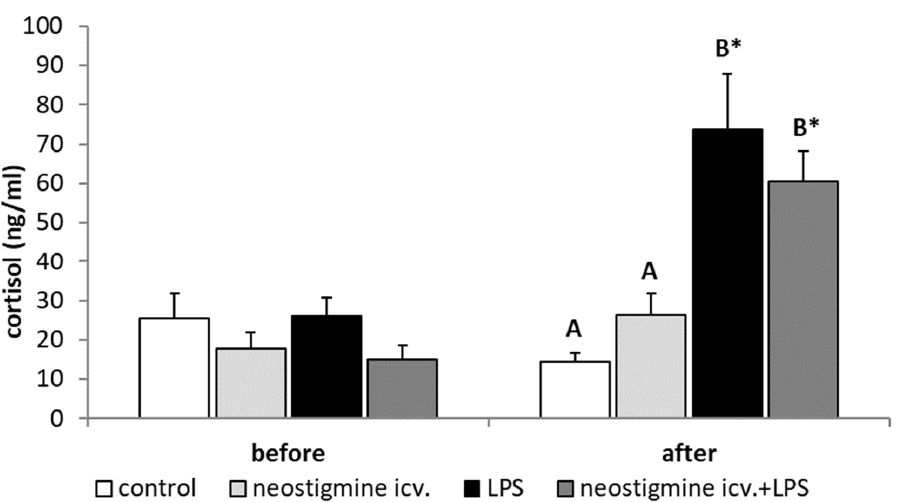
Figure 2. E ff ect of lipopolysaccharide (LPS; 400 ng / kg; intravenous) and neostigmine (1 mg / animal; intracerebroventricular (icv.)) injections on the concentration of cortisol in the blood plasma. The data are presented as the mean value ± S.E.M. ( n = 6 animals per group). All experiments were divided into two periods: a baseline with no treatment (2 to 0.5 h before) and the one after treatment (1 to 3 h after). *—asterisk indicates statistically significant di ff erences between the baseline period and the period after treatment found during a Student’s t -test for dependent samples (“repeated measures”). A two-way ANOVA was used to analyze the concentrations of plasma hormones obtained only after treatment. Significant di ff erences marked with di ff erent capital letters were analyzed by a two-way ANOVA followed by a Fisher’s post hoc test. Statistical significance was stated when p <